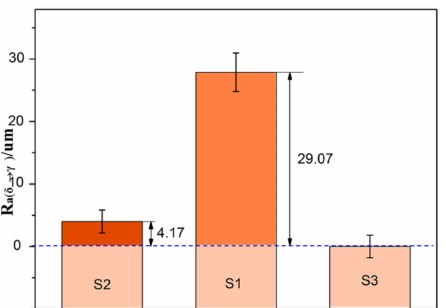
Figure 10. Surface roughness of δ – γ transformation, R a ( δ → γ )